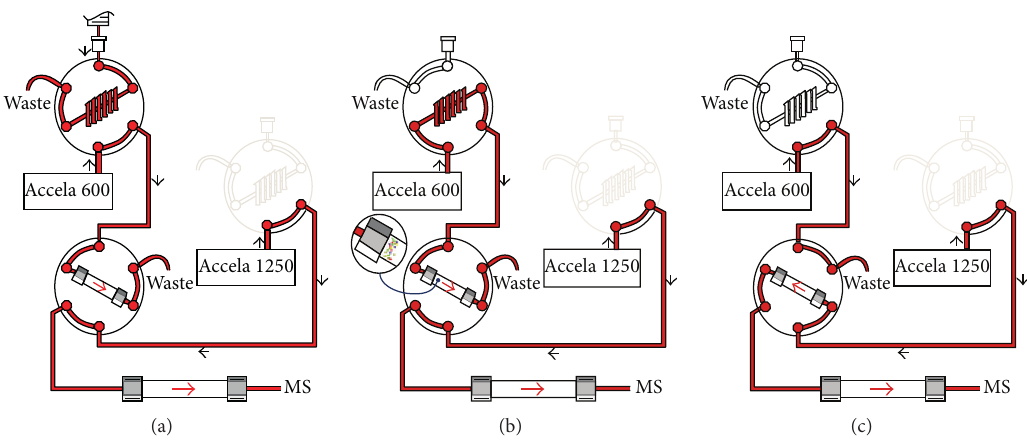
Figure 2: Schematic representation of the on-line SPE system used. (a) Loading of the sample into the high volume loop. (b) Transfer of the sample from the injection loop to the preconcentration column. (c) Transfer of the analytes retained in the preconcentration column to the chromatographic column.